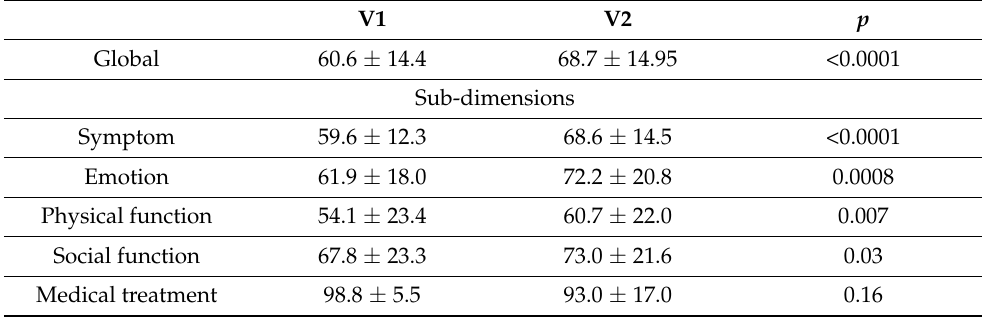
Figure 1. Study flow chart. ITT: intention-to-treat; PP: per-protocol; R: responders; NR: non-responders. Table 1. Impact of a 4-week supplementation with the multistrain probiotic on quality of life, assessed by the Gastrointestinal Quality of Life Index (GIQLI). Global GIQLI score and scores obtained for its sub-dimensions (mean ±